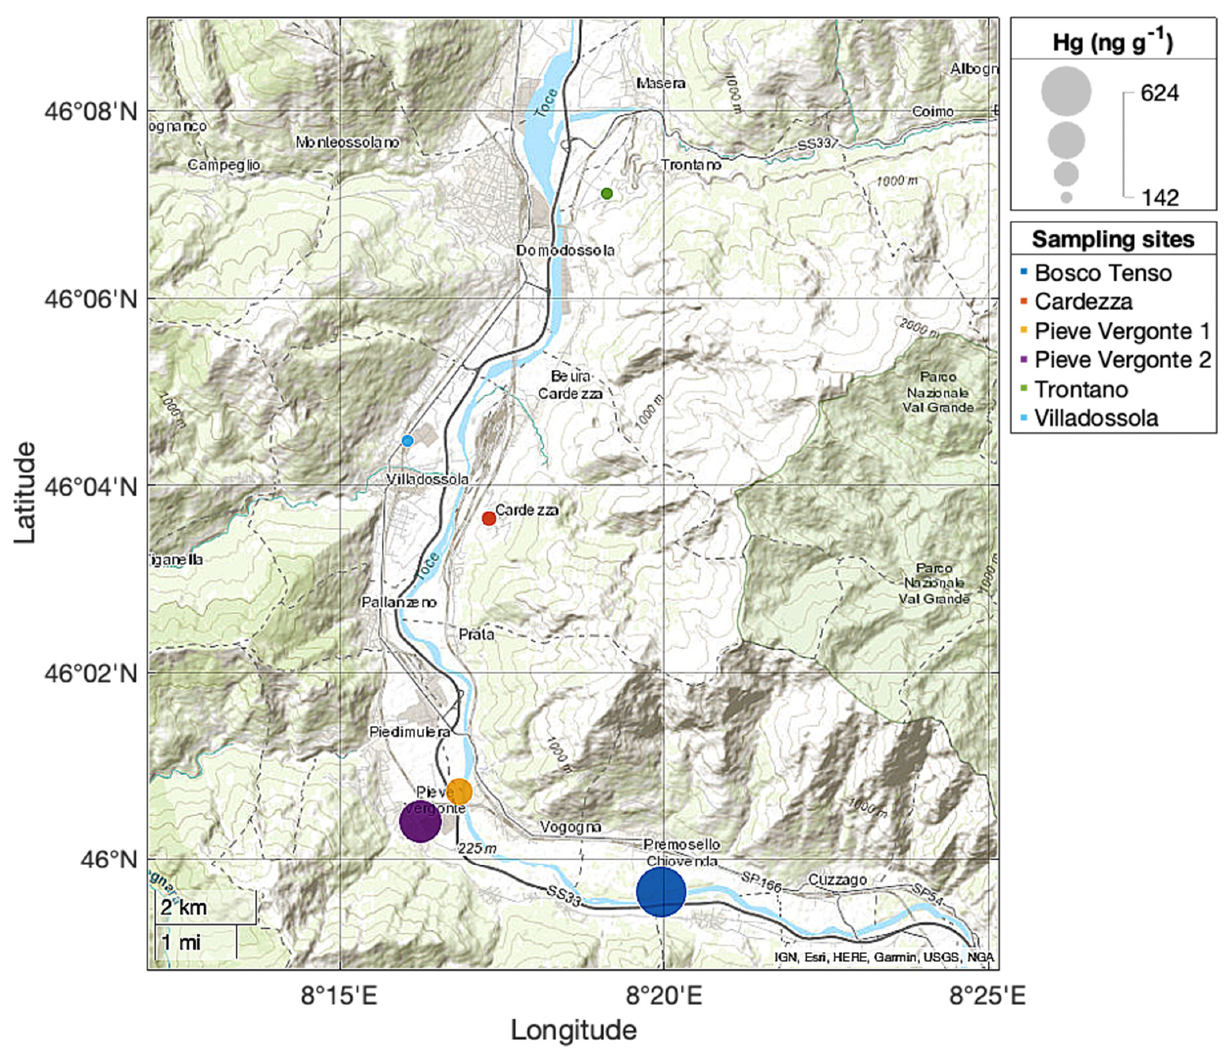
Figure 6. Total Hg concentrations (ng g − 1 d.w.) in lichens of the species P. tiliacea collected in five sampling sites along a North-South transect in the Ossola Valley in March–May 2019. Total Hg concentrations in samples of P. tiliacea collected north of the industrial area showed values significantly lower than those collected in the vicinity of the industrial area. Values were close to background Hg concentrations measured in lichens collected from nonpolluted areas of the northern hemisphere (Table 2). Table 2. Background Hg concentration in lichens collected from clean areas around the world (from [45], modified).